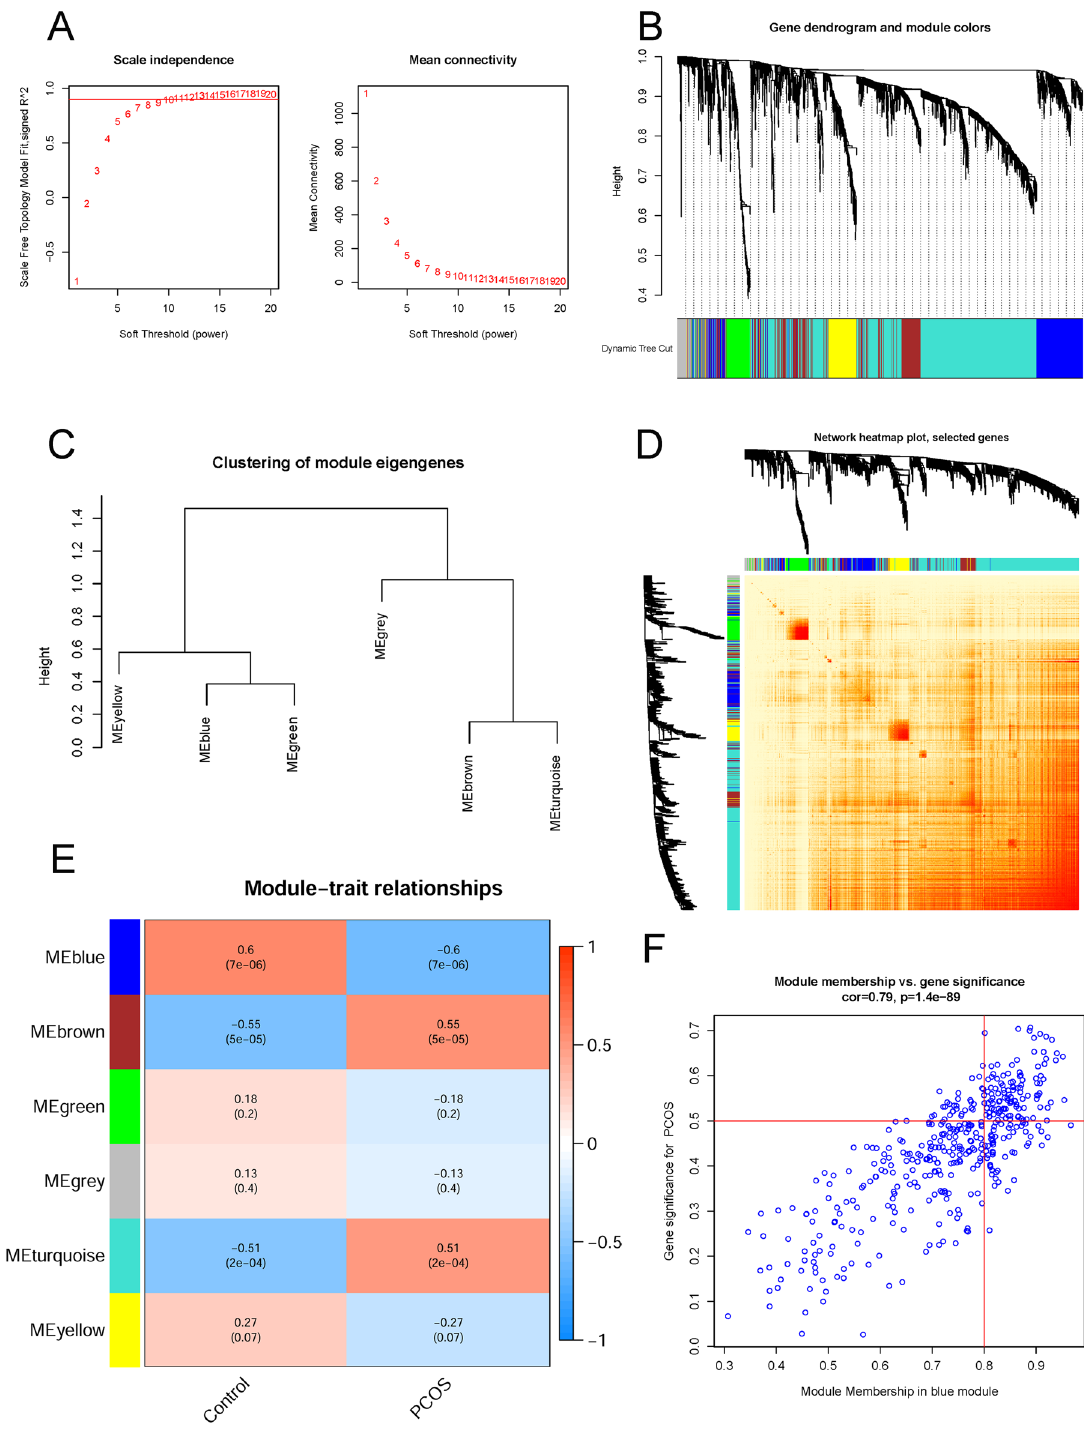
Figure 5. Co-expression network of DEGs in PCOS. ( A ) The option of soft threshold (power). ( B ) Clustering dendrogram of genes in co-expression modules. Distinct co-expression modules were shown in different colors. ( C ) Clustering of module eigengenes. ( D ) The correlations heatmap among 6 modules. ( E ) Correlation analysis between module eigengenes and clinical status. A module is represented by a row, and a clinical status is represented by a column. ( F ) Scatter plot between module membership in blue module and the gene significance for